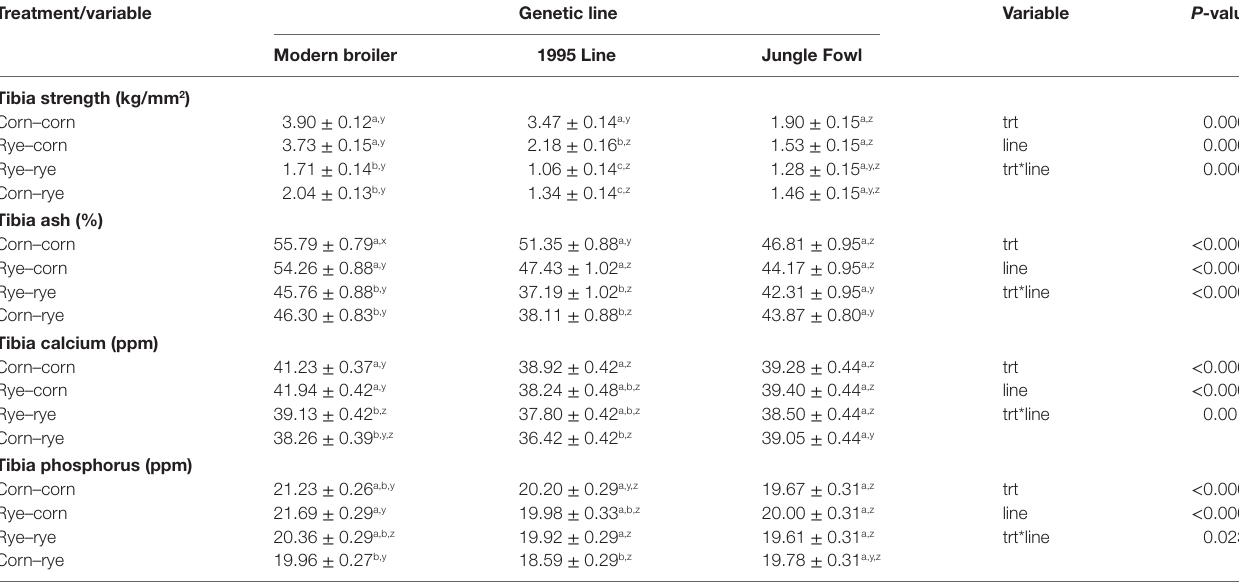
TaBle 4 | Evaluation of a nutritional rehabilitation model on bone parameters in three genetic chicken lines fed rye or corn at varying time points at day 20 of age.